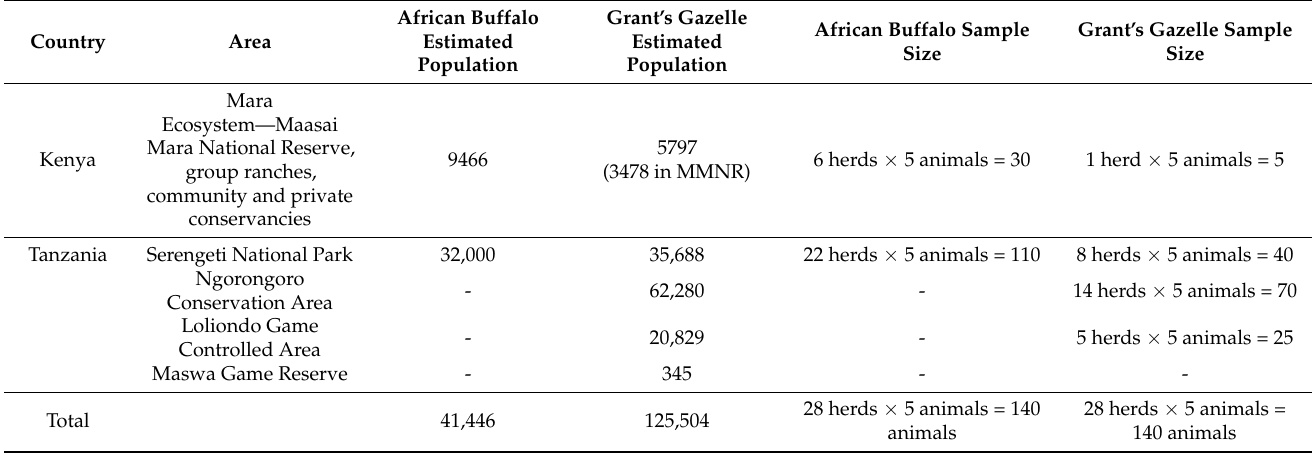
Table 1. Estimated populations of African buffalo and Grant’s gazelle in the Greater Serengeti ecosystem and planned sample